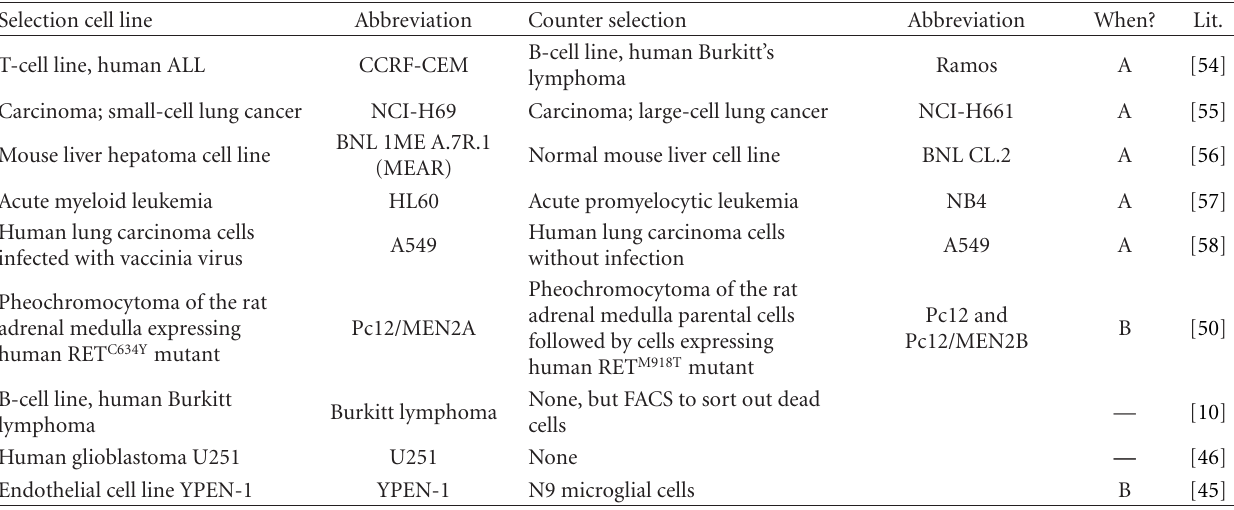
Table 1: Cell-lines used for cell-SELEX and for corresponding counter selection. The column “When?” indicates whether counter selection was performed before (B) or after (A) the selection, or not at all (—). Selection cell line Abbreviation Counter selection Abbreviation When?